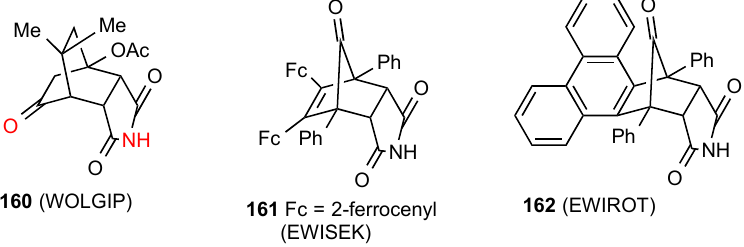
Figure 47. Bicyclo[2.2.1] and [2.2.2]-fused succinimides showing pattern D or no hydrogen bonding.